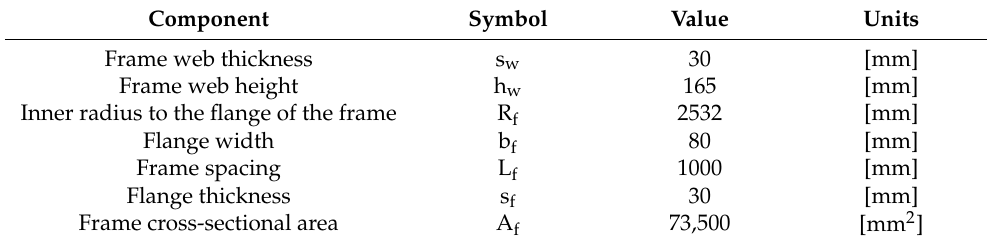
Table 3. Stiffener dimensions for the SFG